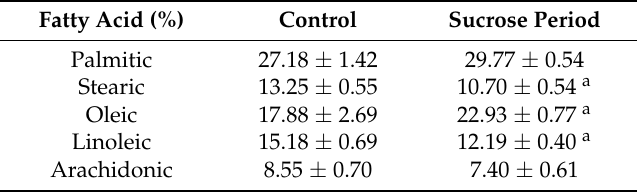
Figure 4. Plasma saturated fatty acids, monounsaturated (MUFA) and polyunsaturated fatty acids (PUFA), in control and sucrose period rats (SP). Data represent mean ± SEM, # p < 0.05, n = 6. Regarding individual fatty acids, oleic acid was significantly increased, while stearic and lionoleic acids were decreased (Table 4). Table 4. Changes in individual serum fatty acids in control and sucrose period rats.